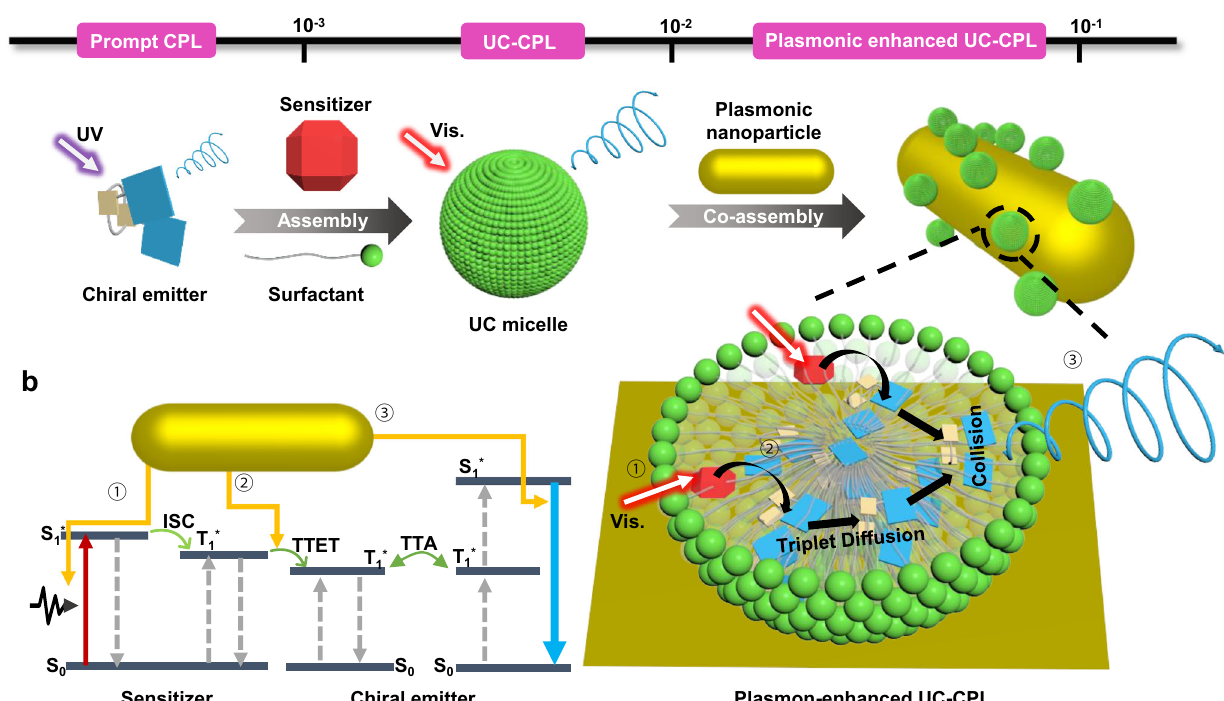
Fig. 1 | Concurrently ampli fi ed dissymmetry factor g lum and upconversion emission from plasmon-micelle composites in aqueous solution. a Under the excitationofUVlight,thechiralemittershowspromptCPLwitha g lum valuearound 1.0×10 − 3 .Whenchiralemitter/sensitizer/CTABmicellesassembleintoupconverted micelles, the high-frequency UC-CPL can be obtained under excitation with low- frequency light. The upconverted micelles exhibit ampli fi ed g lum values between